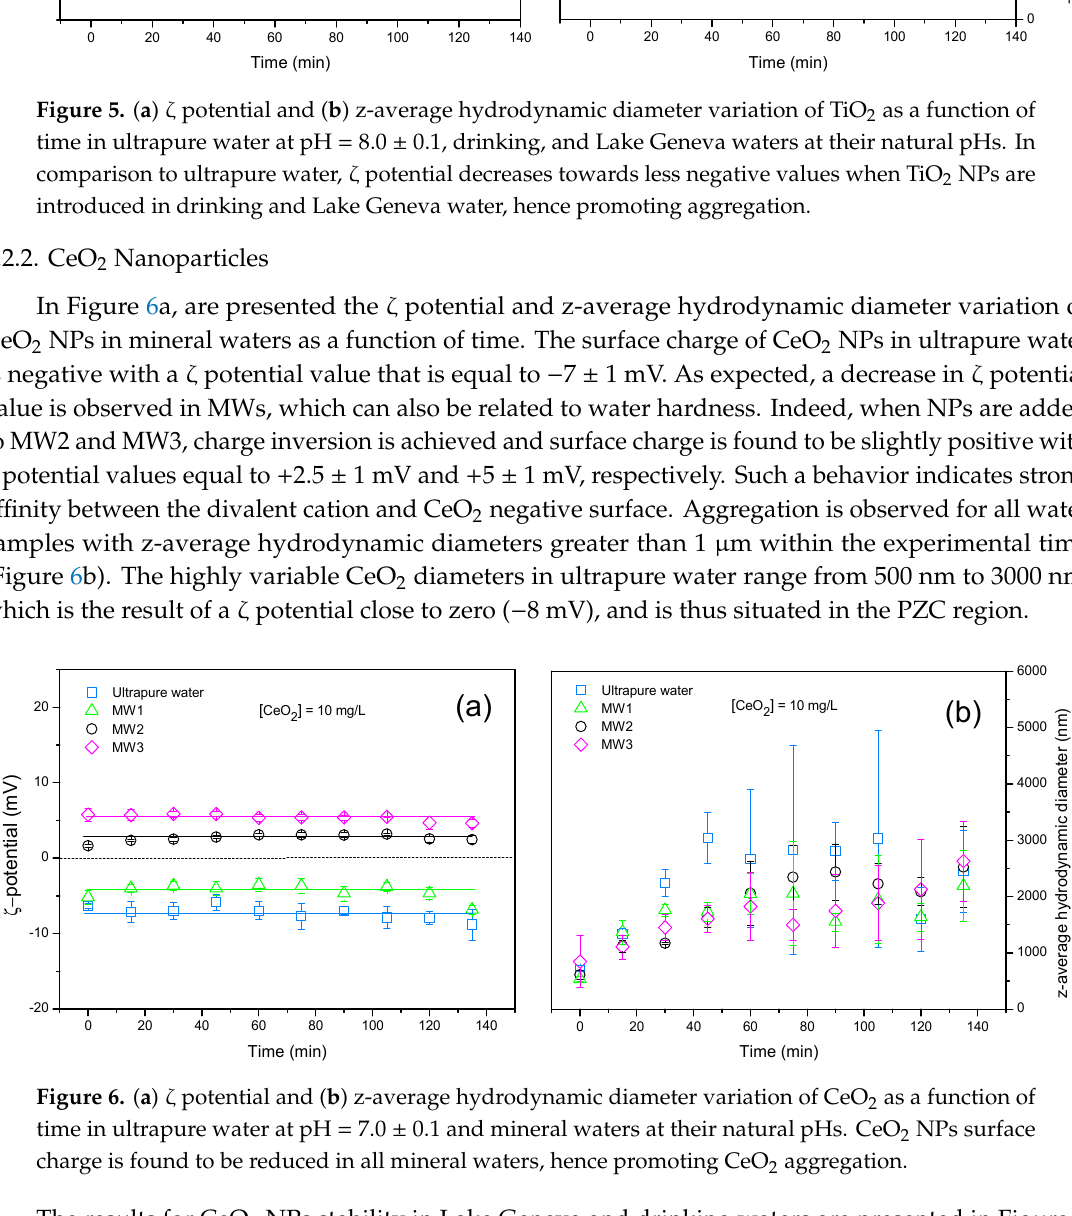
Figure 5. ( a ) ζ potential and ( b ) z-average hydrodynamic diameter variation of TiO 2 as a function of time in ultrapure water at pH = 8.0 ± 0.1, drinking, and Lake Geneva waters at their natural pHs. In comparison to ultrapure water, ζ potential decreases towards less negative values when TiO 2 NPs are introduced in drinking and Lake Geneva water, hence promoting aggregation.